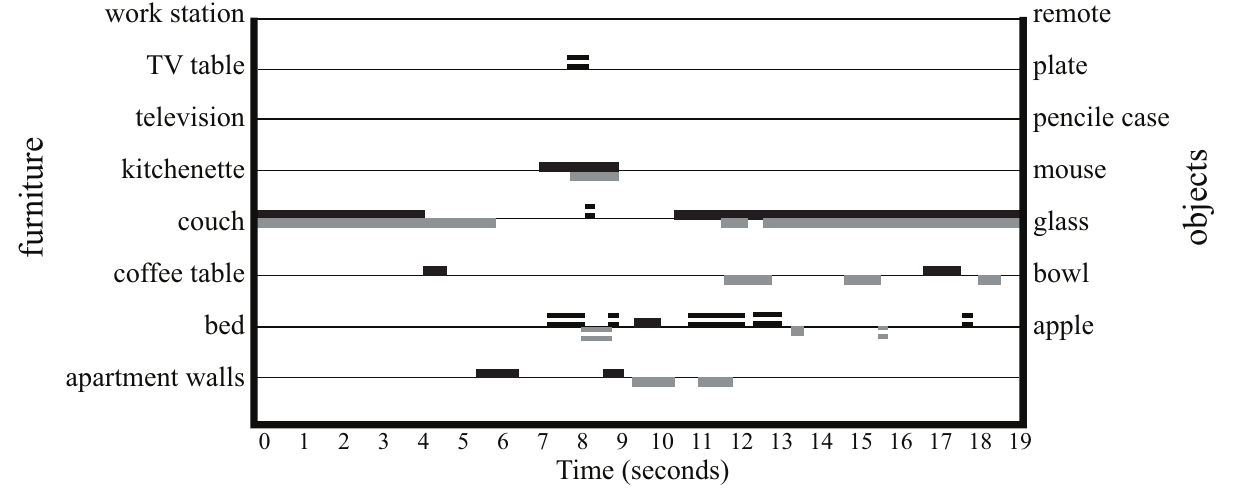
Figure 15. Interaction with the apartment furniture (listed on the left ordinate and read with the solid lines) and apart- ment objects (listed on the right ordinate and read with the horizontally dashed lines) for the right wrist (solid/dashed black lines) and left wrist (solid/dashed grey lines). The abscissa represents time in seconds. Detected interaction is illustrated by lines. An example of reading the figure would be: the right wrist was interacting with the glass (dashed black line) at the kitchenette (black solid line) around the 8.5 second mark.